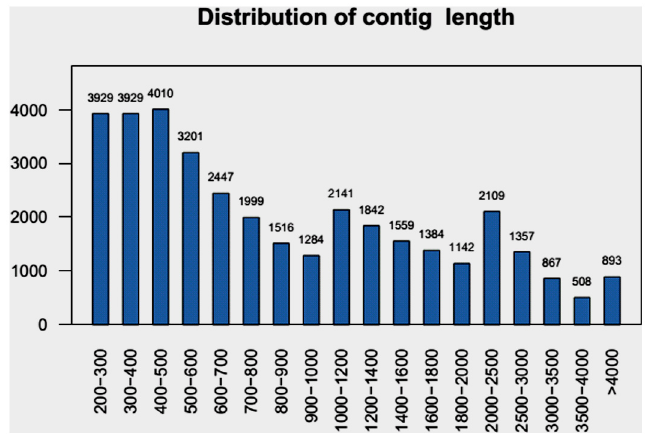
Fig 4. Distribution of contig length. The X-axis indicates contig length (bp). The Y-axis indicates number of